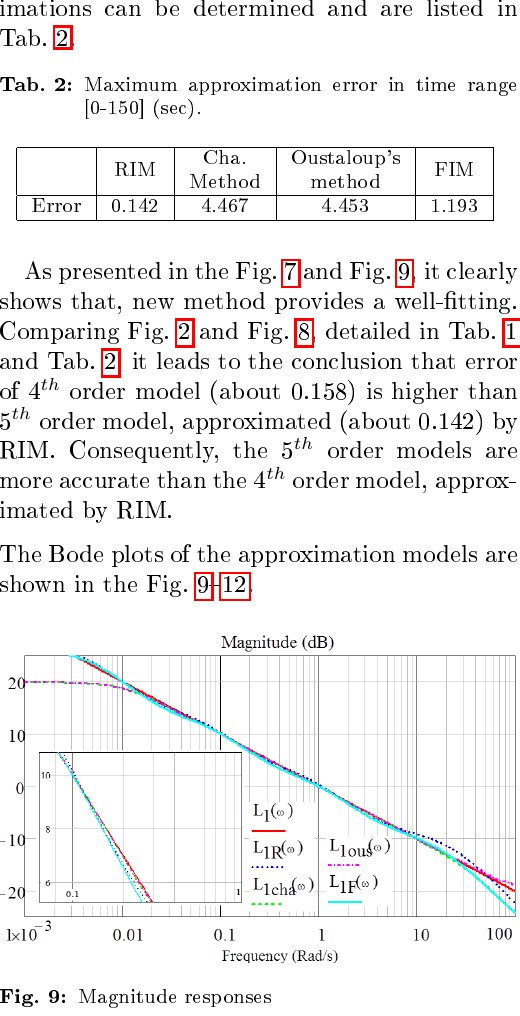
According to the Fig. 8, the maximum approx- imations can be determined and are listed in Tab. 2.